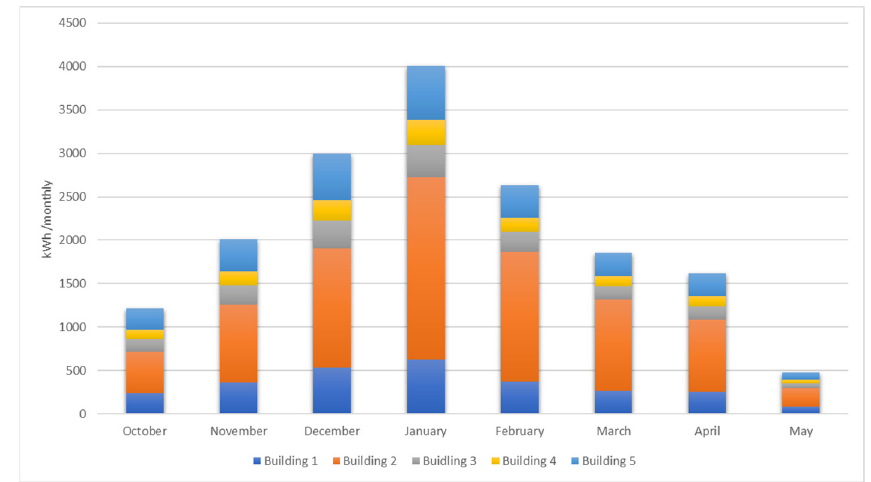
Energies 2022 , 15 , x FOR PEER REVIEW Figure 6. Baseline energy consumption for heating. Figure 6. Baseline energy consumption for heating.